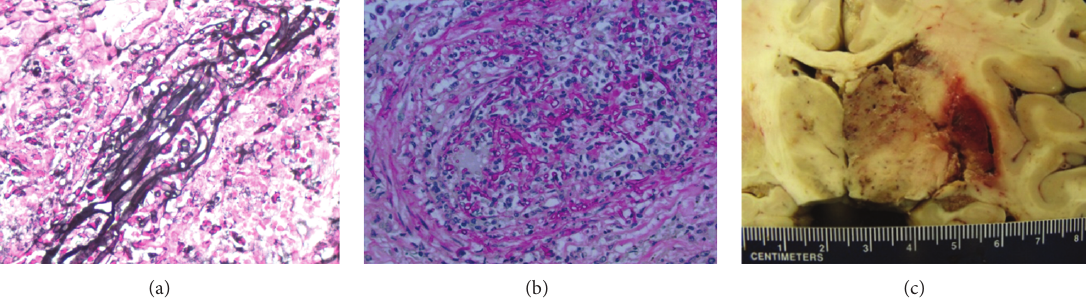
Figure 2: Light microscopy of the transplanted kidney biopsy ((a), Jones stain, 400x) and lung tissue ((b), PAS stain, 400x) showing fungal hyphae. (c) Necrotic and hemorrhagic lesion in the right cerebral